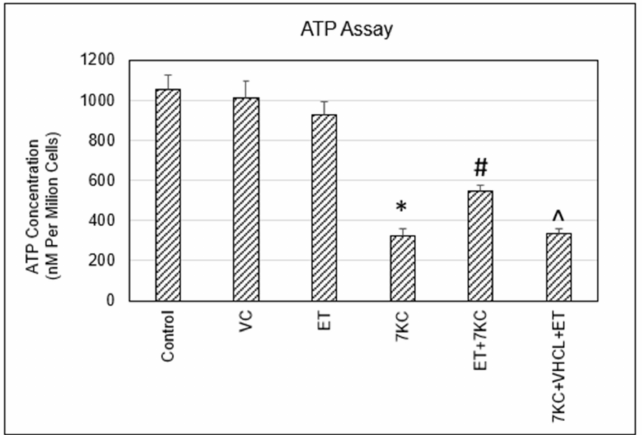
Figure 6. Cellular ATP levels. 7KC treatment resulted in a significant decrease in ATP production, and this decrease was significantly inhibited by ET. Coincubation with VHCL abrogated the protective effect of ET. VC: Vehicle control; ET: 1 mM ET; VHCL: 100 µ M VHCL; 7KC: 30 µ M 7KC. Data are represented as the mean ± SD (n = 3). * Significant difference compared to controls ( p < 0.05). # Significant difference compared to 7KC. ˆ Significant difference compared to ET + 7KC. Data were analysed by one-way ANOVA with Bonferroni’s multiple comparison post-hoc